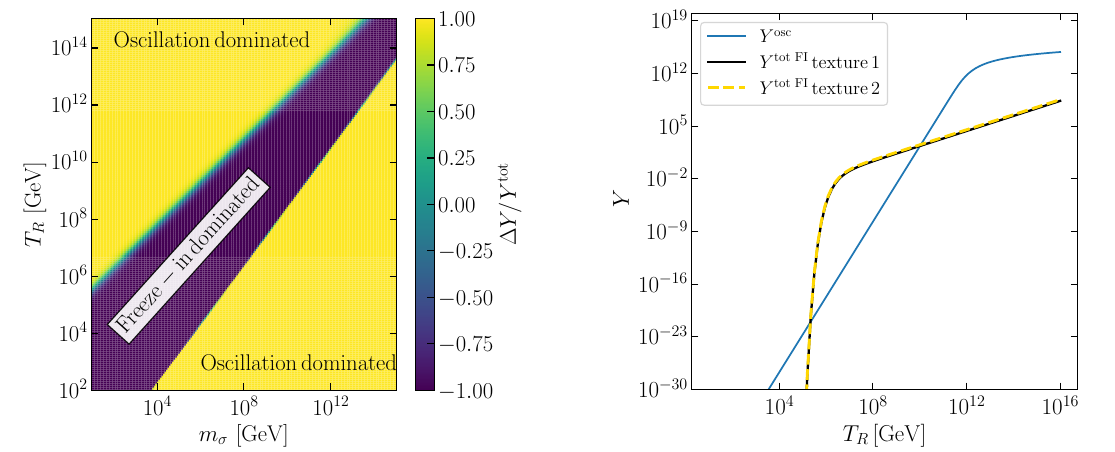
Figure 1 . Plot showing in which regions of parameter space the yield Y is dominated by either freeze-in or oscillation production mechanism for the flavon. ∆ Y = Y osc . − Y FI . . Left: a heatmap where the yield is dominated by production from oscillations (yellow) or freeze-in (dark blue). Right: the yield for oscillation production (blue) and freeze-in of texture 1 Equation (3.5) (black solid) and texture 2 described in the paragraph below Equation (3.5) (yellow dashed). The flavon mass has been fixed to m σ = 10 5 GeV and a range of T R values are